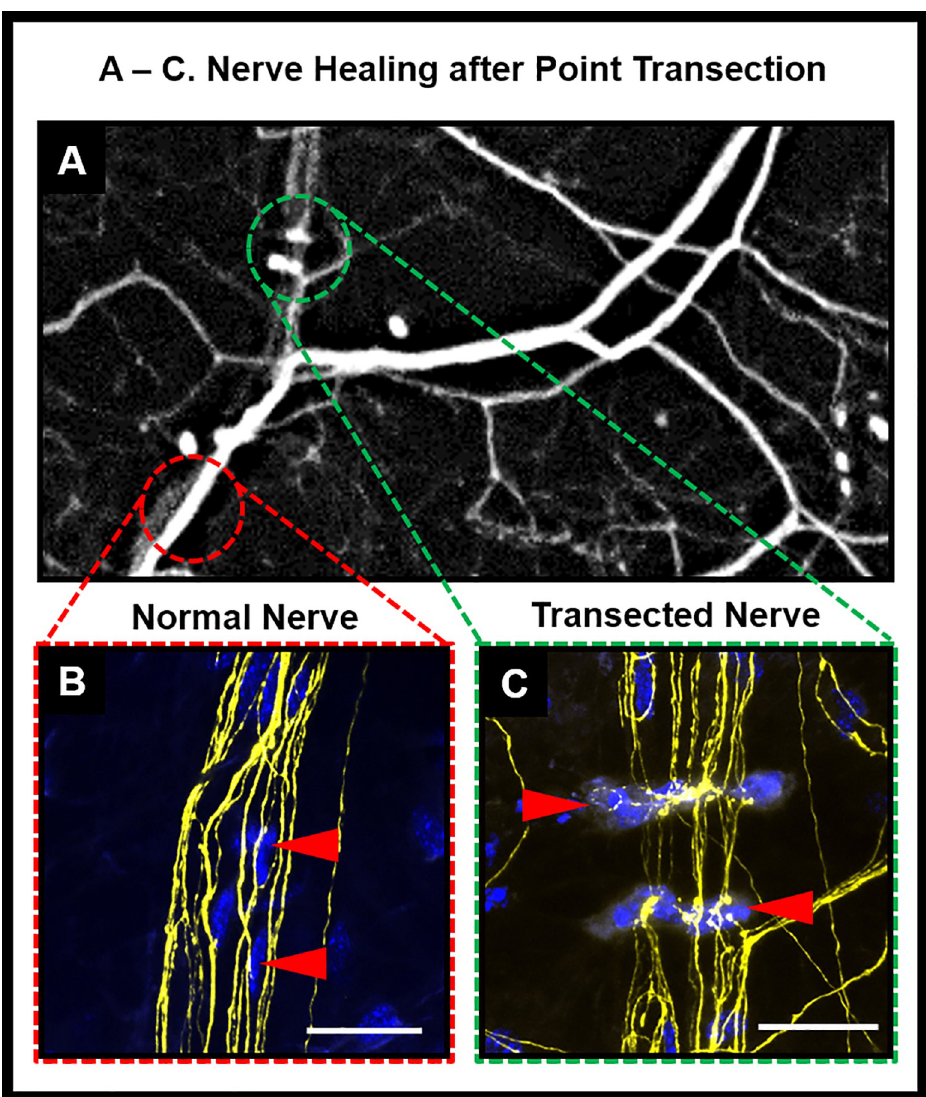
Fig 5. Nerve healing after point transection. (A): Magnified area of a stereofluorescent image of cornea two weeks after point transection (green dotted lines mark the transected area with cells; red dotted lines mark intact area of a normal untransected region along the nerve (B) inset shows magnified view of normal untransected nerve with cells oriented parallel along the nerve fibers (C) inset shows magnified view of transected area two weeks after ablation with cells oriented in perpendicular direction to the